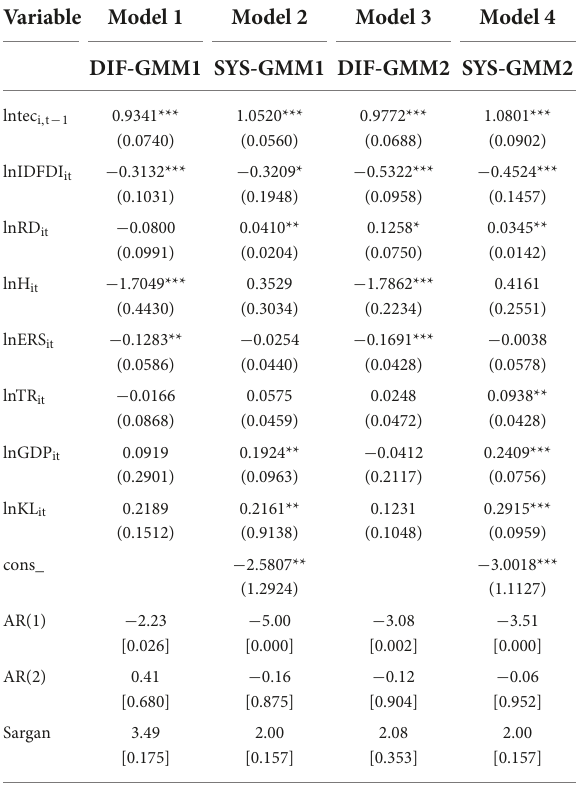
TABLE 6 Environmental technology effects of two-way foreign direct investment (FDI) interactive